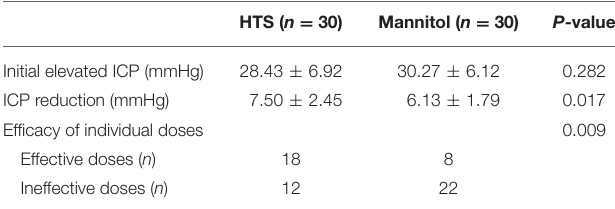
TABLE 3 | Response to individual boluses in the two groups.